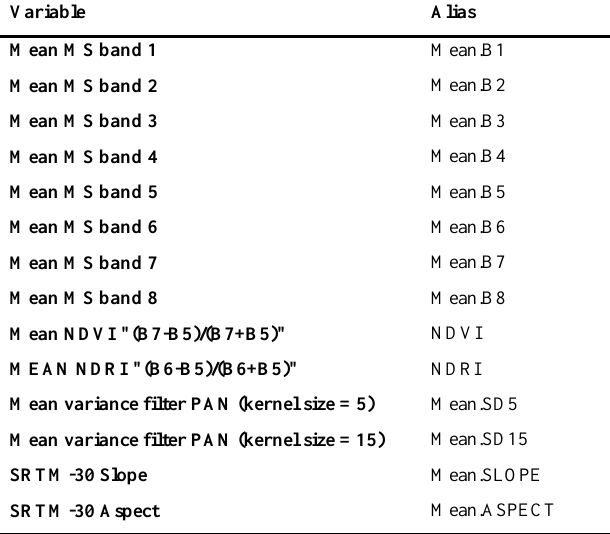
Table 2. Predictor variables for the area-wide estimation of Vegetation Cover Fraction (VCF).